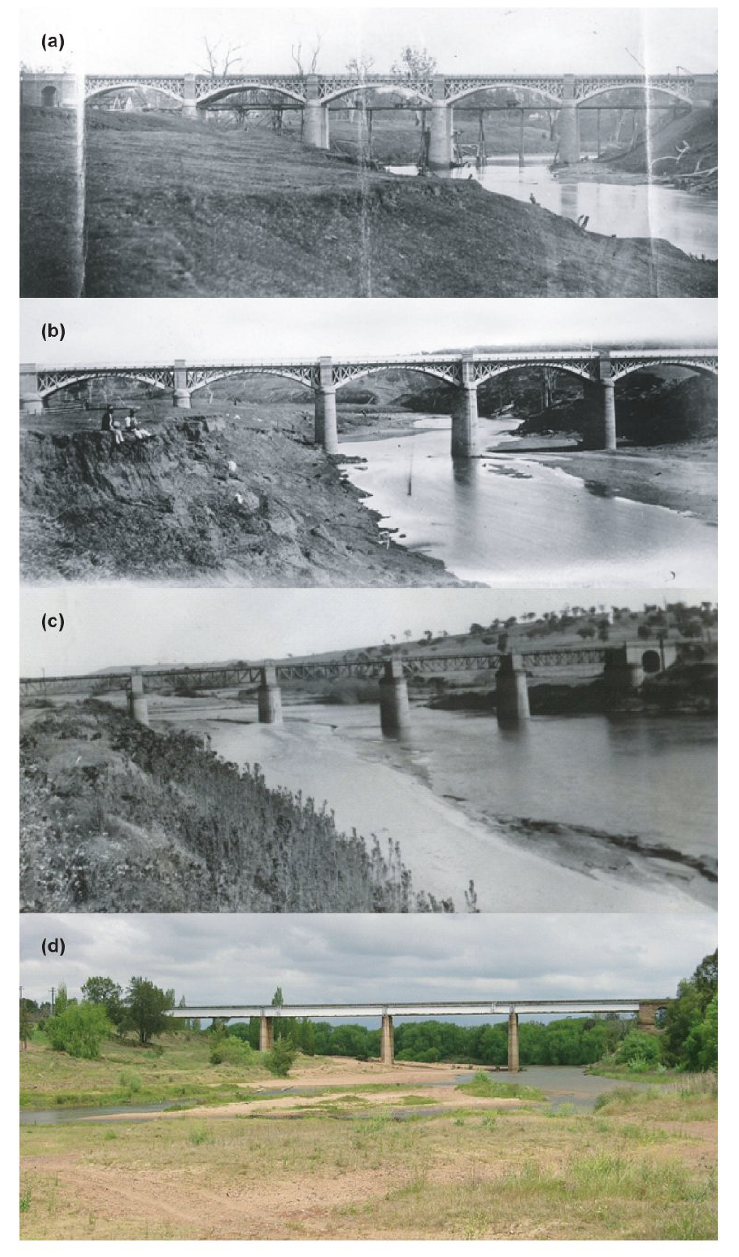
Fig. 4 . The Hunter River at the Singleton rail bridge in (a) 1861, (b) 1866, (c) 1963, and (d) 2003. Note the ringbarked (dead) trees in (a), the actively eroding bank and lack of instream wood in (b), the expansion of the macrochannel in (c), and the reestablishment of a riparian zone (albeit dominated by exotic Salix spp.) as well as the contraction of the low-flow channel in (d). [Photos (a) through (c) are courtesy the NSW Department of Environment, Climate Change and Water historical photo. Photo (d) is by N. Cook, NSW Department of Environment, Climate Change and